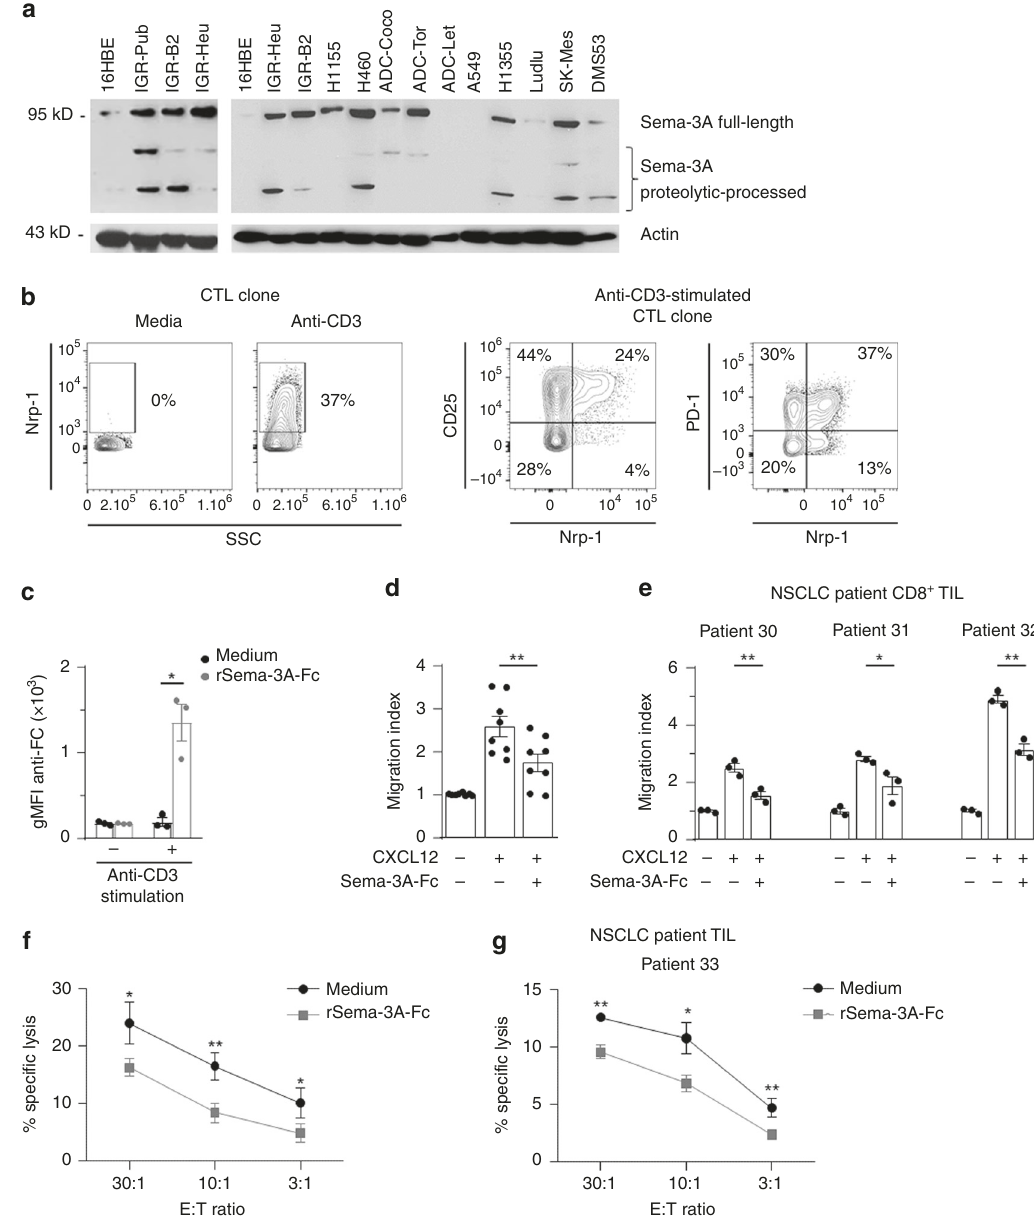
Fig. 2 Expression of Sema-3A and Nrp-1 in human lung tumour cell lines and CTL clone. a Sema-3A expression in human lung tumour cell lines. Total protein extracts were analysed by western blot using anti-Sema-3A mAb. The 16HBE cell line was included as a control. Full length and proteolytically processed proteins are indicated. b Co-expression of Nrp-1 and CD25, and Nrp-1 and PD-1 on P62 T cells stimulated with immobilised anti-CD3. c The P62 clone was unstimulated or stimulated with anti-CD3, pre-incubated with Sema-3A-Fc, and then labelled with anti-human IgG-Fc secondary mAb. Results are gMFI mean ± SEM of triplicate samples. d Sema-3A-Fc inhibits CTL migration toward a CXCL12 gradient. The T-cell clone was stimulated with anti- CD3, pre-incubated with BSA or Sema-3A-Fc, and then seeded in the upper chambers of transwell plates and exposed to a gradient of CXCL12 loaded in the lower chambers. The number of T cells that had migrated into the lower chambers was determined. Results are mean chemotaxis index ± SEM of triplicate samples. e Sema-3A-Fc inhibits CD8 + TIL migration toward CXCL12. CD8 + TIL isolated from three human NSCLC tumours were stimulated with anti-CD3, pre-incubated with BSA or Sema-3A-Fc, and then seeded in the upper chambers of transwells and exposed to a CXCL12 gradient. Results are mean chemotaxis index ± SEM of triplicates. f Cytotoxicity of the CTL clone toward autologous tumour cells. The P62 clone was stimulated with anti-CD3, pre-incubated in medium or with Sema-3A-Fc. Cytotoxicity toward the cognate IGR-Pub cell line was determined. g Cytotoxic activity of freshly isolated TIL toward autologous tumour cells. TIL, freshly isolated from a NSCLC tumour, were stimulated with anti-CD3, pre-incubated in medium or with Sema-3A-Fc. Cytotoxicity toward freshly isolated autologous tumour cells was determined. Data shown for cytotoxic assay correspond to one of three independent experiments. Means ± SEM two-tailed Student ’ s paired t test c , one-way ANOVA test with Bonferroni correction d , e or two-way ANOVA test with Bonferroni correction f , g . * P < 0.05; ** P < 0.01; *** P < 0.001. Source data are provided as a Source Data fi le